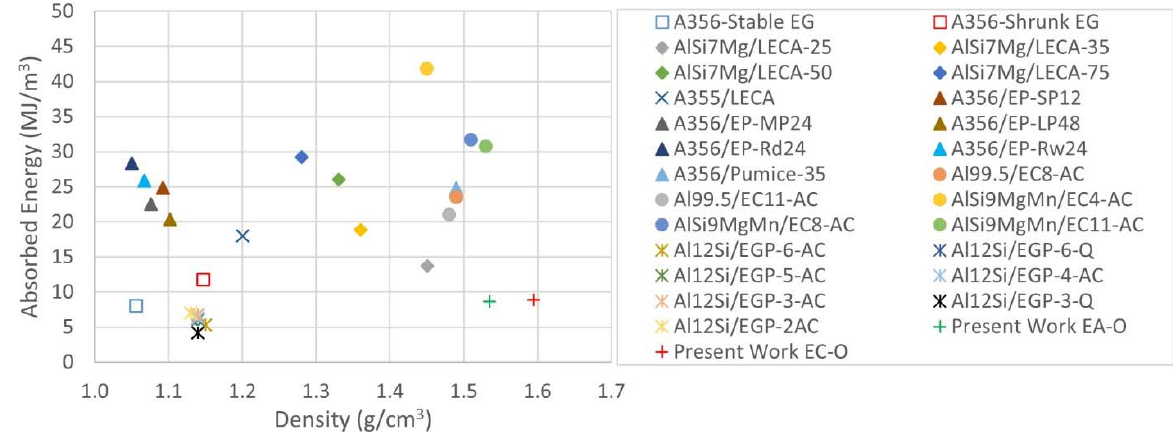
Figure 11. Comparison of average values of energy absorption capacity of ASF-embedding porous fillers [11–15,20–22].